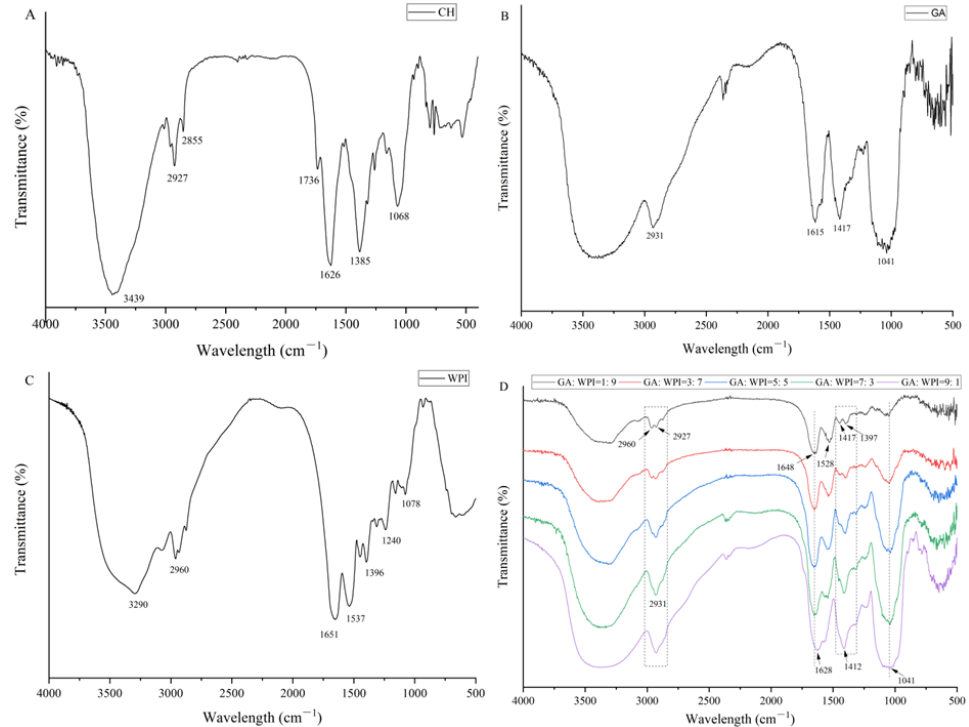
Figure 1. FT-IR spectra of CH ( A ), GA ( B ), WPI ( C ) and microcapsules ( D ) were prepared by different ratios of GA:WPI.